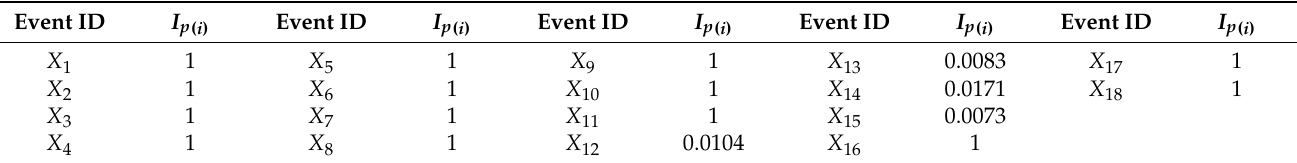
Table 1. The probability importance of basic